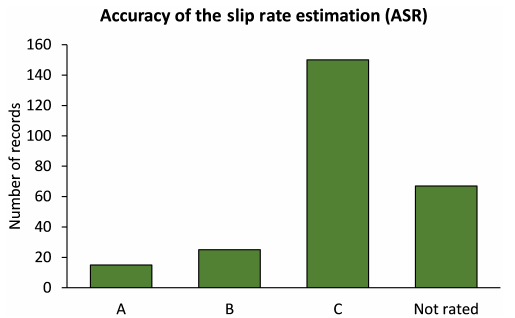
Figure 3. Distribution of classes of accuracy of the slip rate estima- tion (ASR) in QAFI v.3 database. See text for further